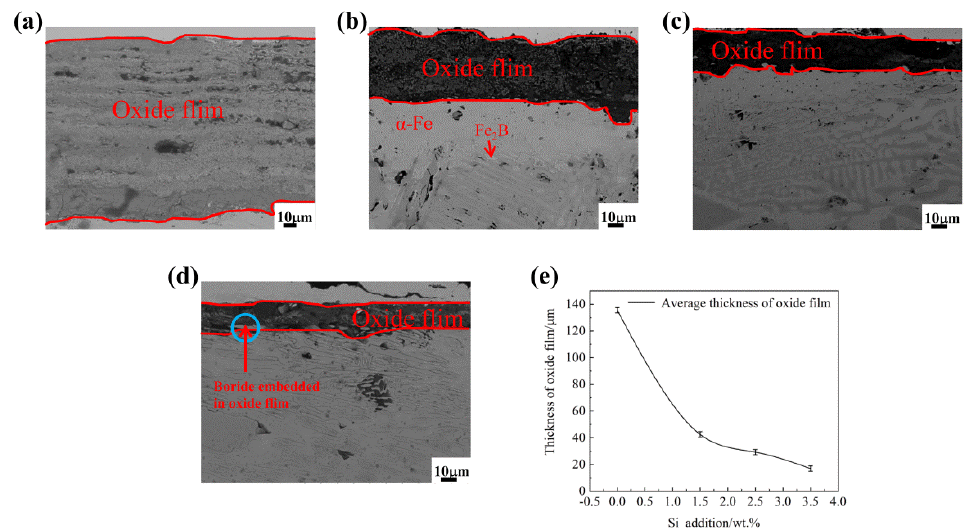
Figure 10. The BSE micrographs of the cross-section of Fe 2 B ⊥ samples oxidized for 60 h at 1073 K: ( a ) alloy A1, ( b ) alloy A2, ( c ) alloy A3, ( d ) alloy A4, ( e ) the thickness of cross-sectional oxide film.